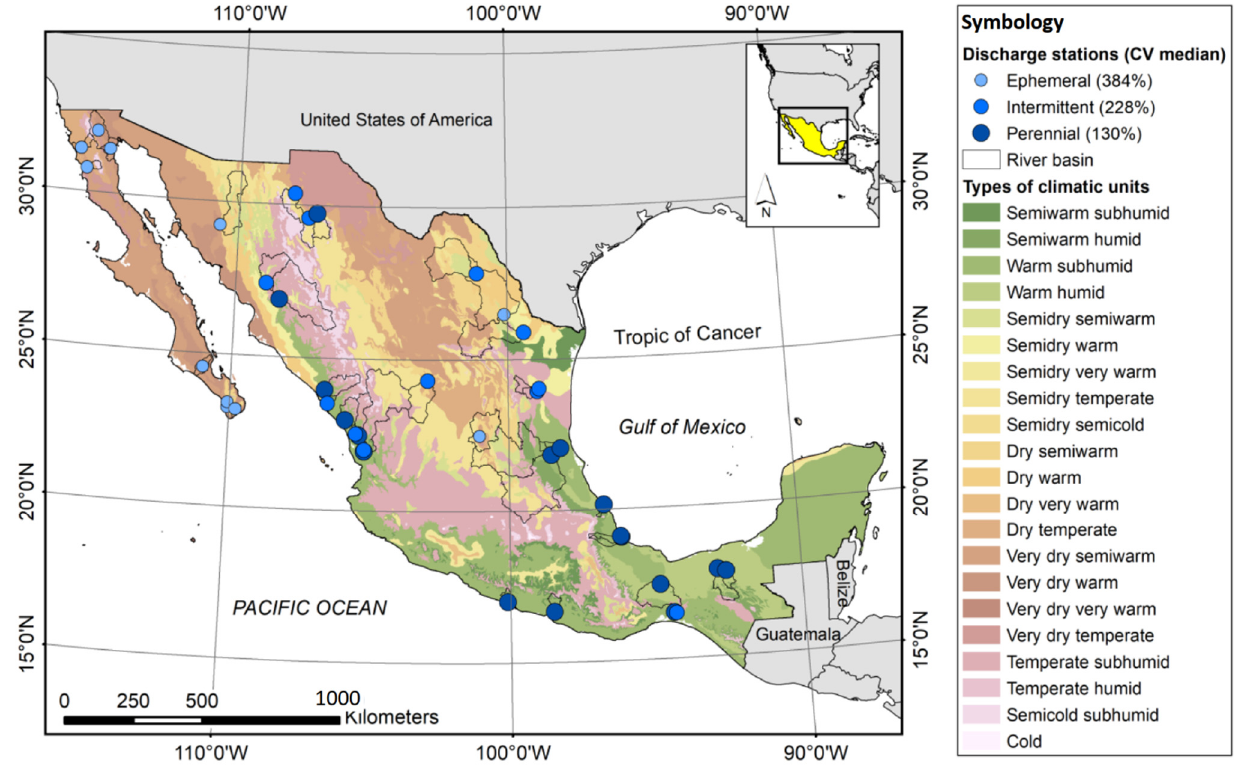
Figure A2. Location of study basins, flow type at the gauged point, the median of the coefficient of variation (CV), and types of climates based on the Köppen climatic classification system.